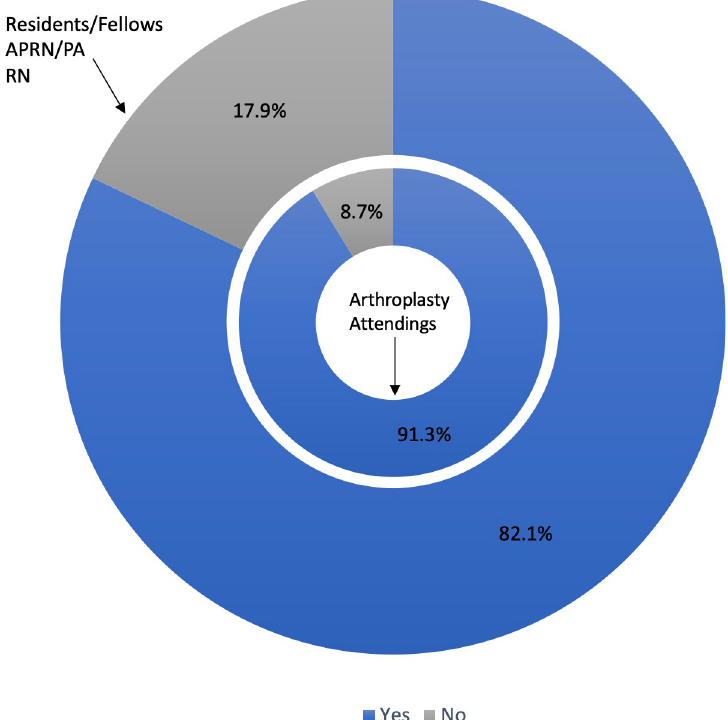
Fig 4. Clinicians willingness to use/suggest using a lower expense item. Clinicians indicated their willingness to use or suggest using a lower expense item if they were aware of cost differences of clinically similar items. The inner doughnut chart present results from arthroplasty attendings, while the outside doughnut chart presents results from all other respondents.